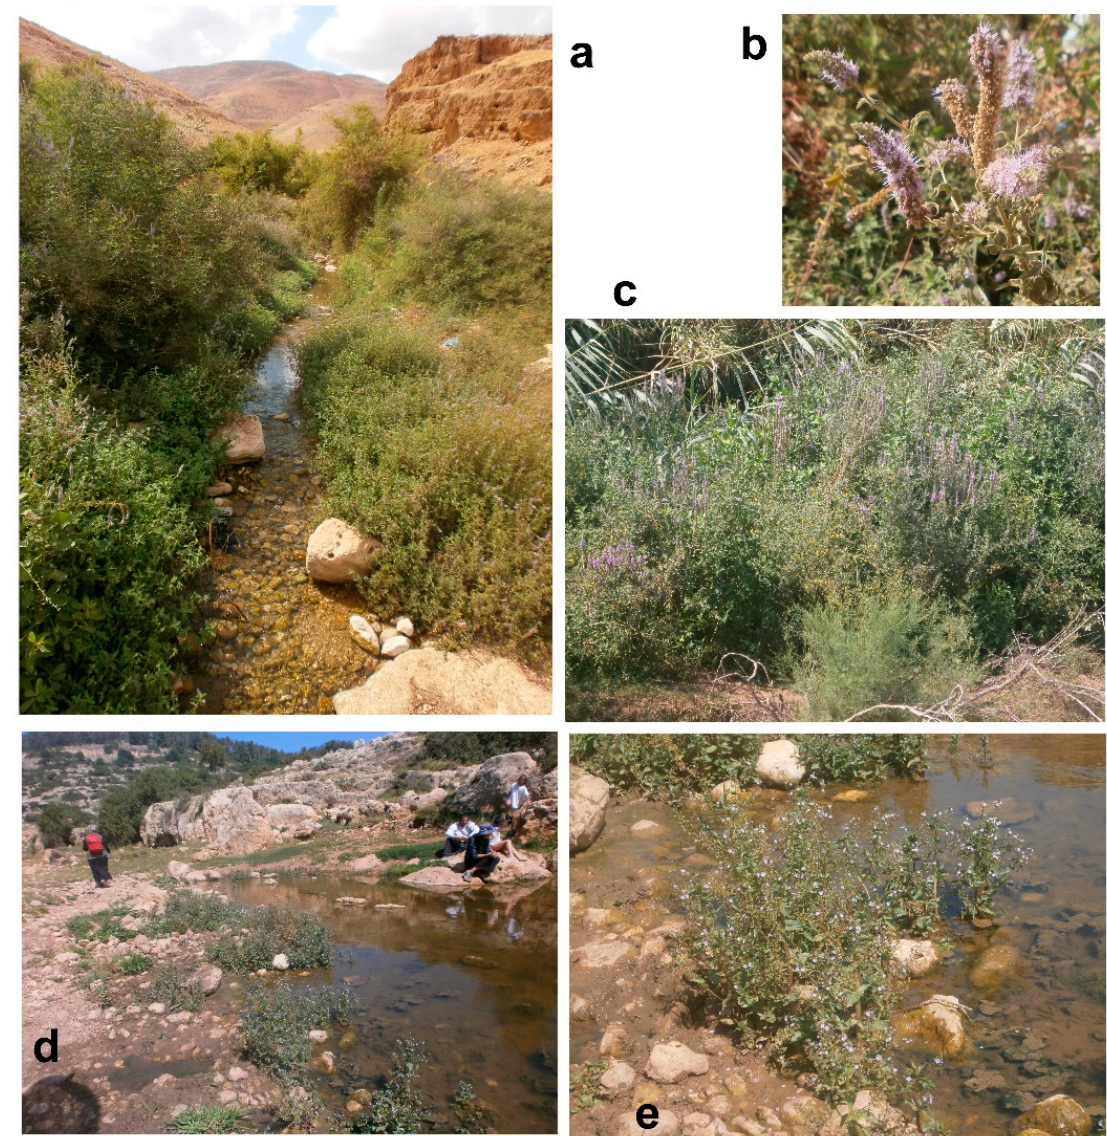
Figure Figure 2. ( a ) ‘En Peza`el, Nahal Peza`el, Jordan Valley, Mentha longifolia , Vitex agnus-castus , Ziziphus spina-christi ; ( b ) same place, blooming Mentha longifolia ; ( c ) Arik Bridge, bank of the Jordan River, Lythrum salicaria , Melilotus albus , Phragmites australis and Tamarix sp.; ( d ) Nahal Qana, Turtles Pond, Samarian Hills, Veronica anagallis-aquatica growing along the water; ( e ) same place, Veronica anagallis- aquatica .